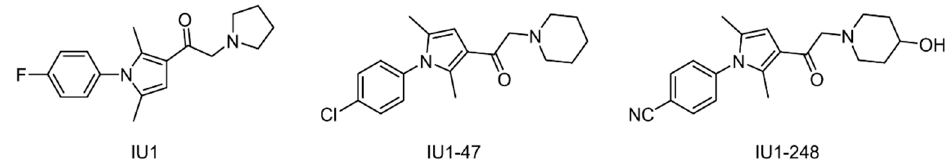
Figure 22. Structures of representative USP14 inhibitors.